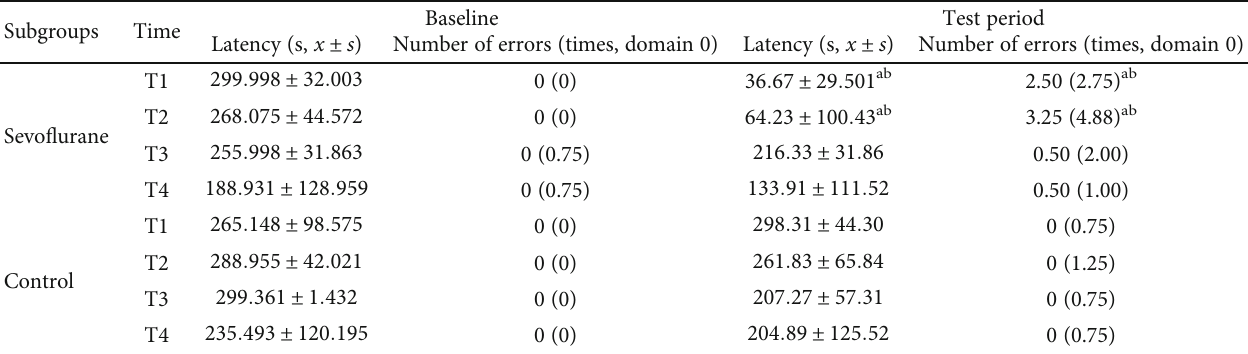
Table 2: E ff ect of sevo fl urane on indicators in the step-through latency test of mice ( n = 8 ). Subgroups Time